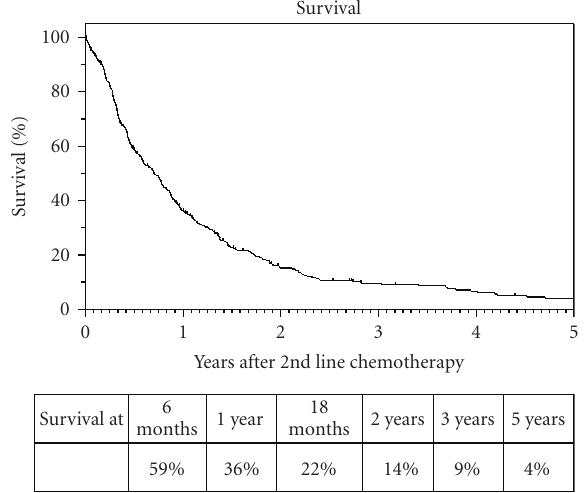
Figure 2: Overall